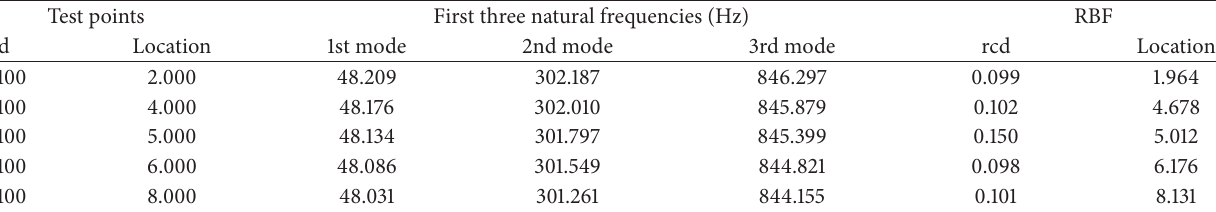
Table 3: Input data and results for RBF network.